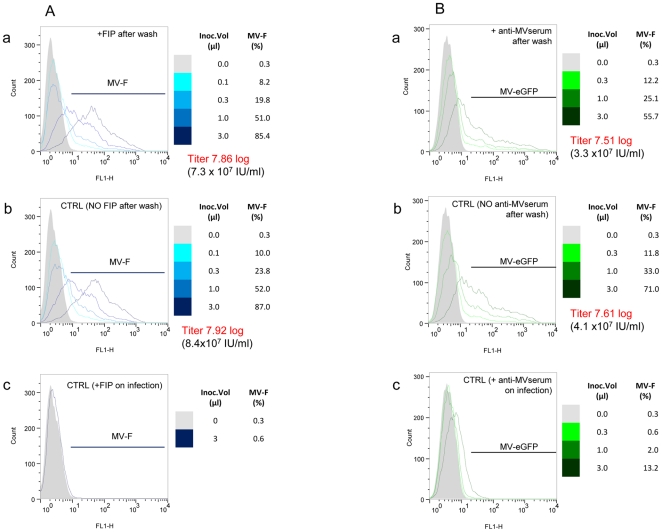
Determination of the duration of a single virus replication cycle and the reading time for titration.
(A) The rapid method for MV titration is based on a single infection cycle. Vero cells were inoculated with MV-Halle strain for 6 hours. Then, they were washed with PBS to eliminate residual virus. Medium supplemented or not with 0.1 mg/ml of the fusion inhibitory peptide (FIP) was then added. At 18 h.p.i., cells were analyzed by flow cytometry and similar titers were found in both cases (i.e. with and without FIP) (Compare “a” 7.86 Log IU/ml and “b” 7.92 Log IU/ml. As a control for FIP efficiency, its addition just before the virus inoculation completely prevented MV infection “c”. (B) Validation of estimated virus cycle duration as reading time for titration. Similar titers were obtained after inhibition of secondary infection by anti-measles serum. Vero cells were infected with MV-eGFP for 6 hours, then washed with PBS and further incubated in the presence “a” or absence “b” of a potent neutralizing antiserum. “c” - neutralization efficiency of the anti-serum upon addition to the virus inoculum prior to infection. Note for the highest inoculum volume, a small GFP background signal was detected due to the low amount of GFP embarked into the input virus particles.